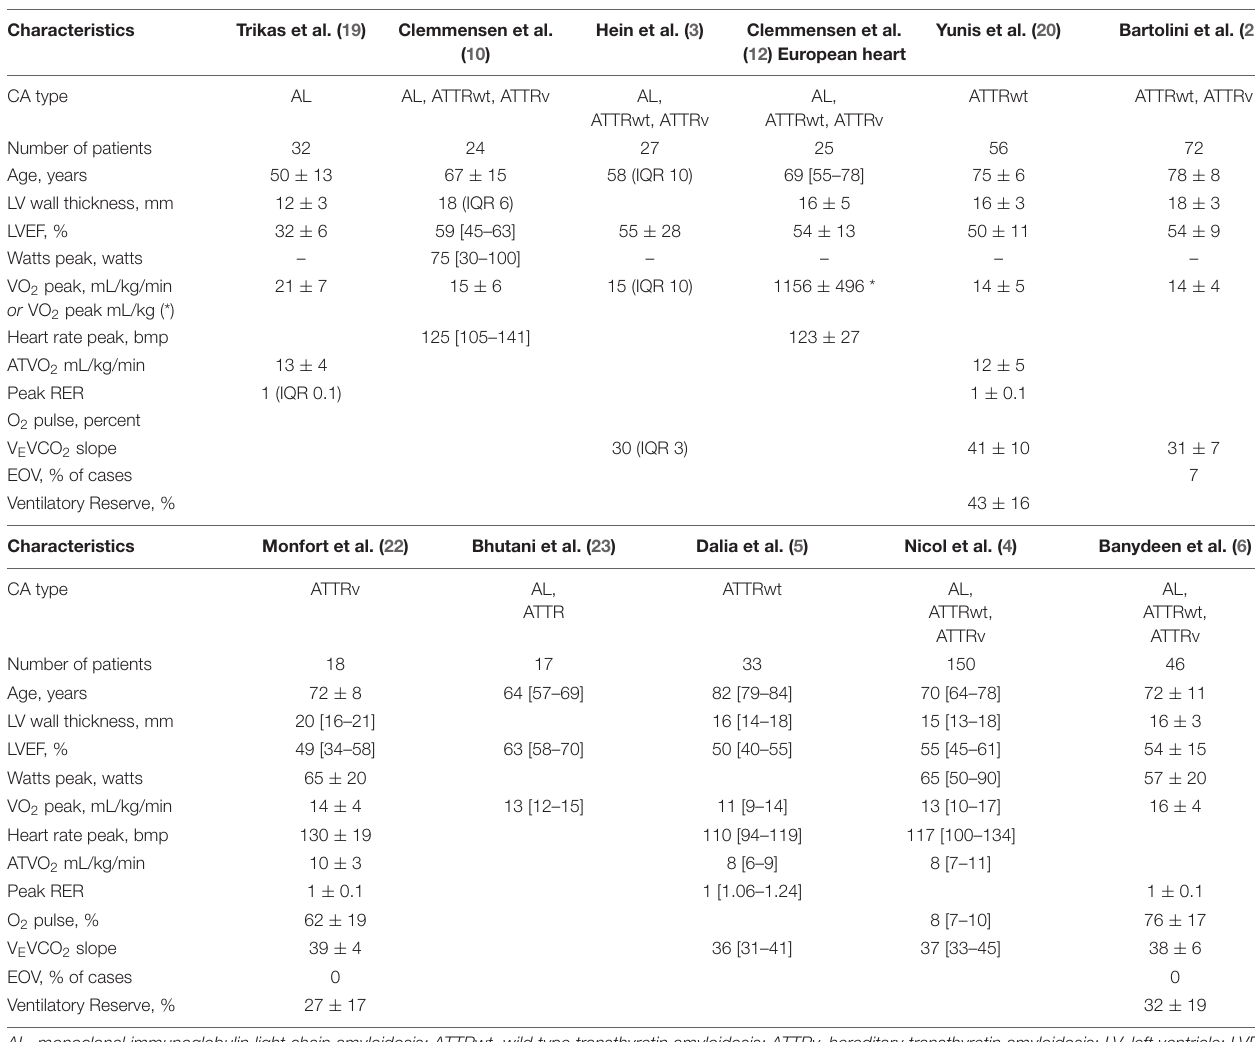
TABLE 1 | Main characteristics of cardiopulmonary exercise testing (CPET) in patients with cardiac amyloidosis (CA).